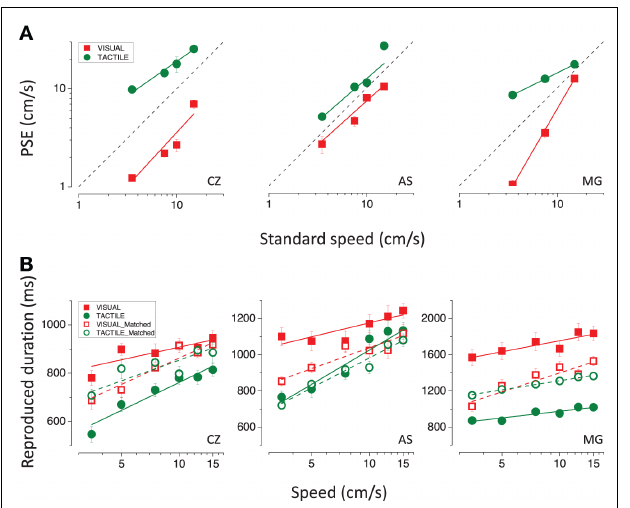
FIGURE 7 | (A) Point of subjective equalities for the visual (in red) and tactile (in green) stimuli as a function of tactile and visual standard speeds (3.5, 5, 7.5, 10, 12.5, 15cm/s), respectively.The dashed line represents the equality line. (B) Reproduced durations plotted as a function of speed for the 600ms visual (in red) and tactile (in green) moving stimuli. Filled symbols represent the results for the visual and tactile stimuli moving at the same physical speeds (standard speeds). Red open symbols represent the results for the visual stimuli matched in perceived speed to the tactile stimuli moving at the standard speeds (filled green symbols); green open symbols represent the results for the tactile stimuli matched in perceived speed to the visual stimuli moving at the standard speeds (filled red symbols); results for all subjects.